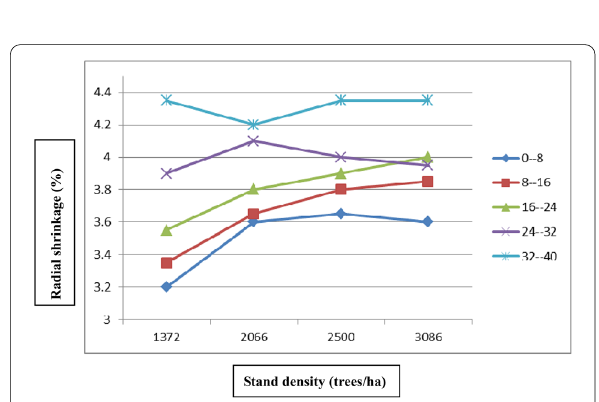
Fig. 9 Longitudinal shrinkage in relation to log height and stand density